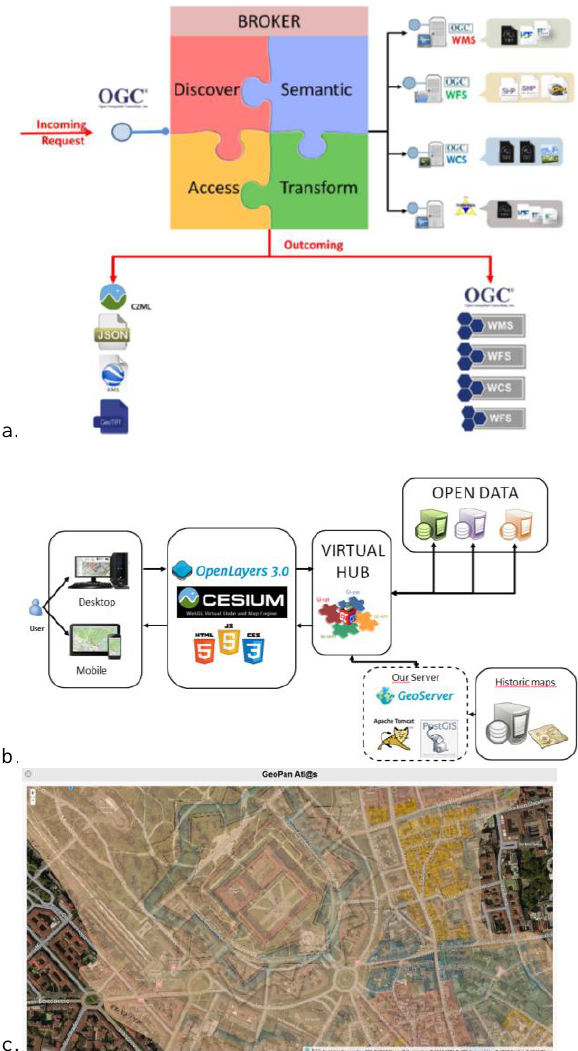
Figure 4. The broker architecture for heterogeneous data discovery and access (a), the architecture of the developed mobile application (d) and the visualization of historical maps trough the developed application